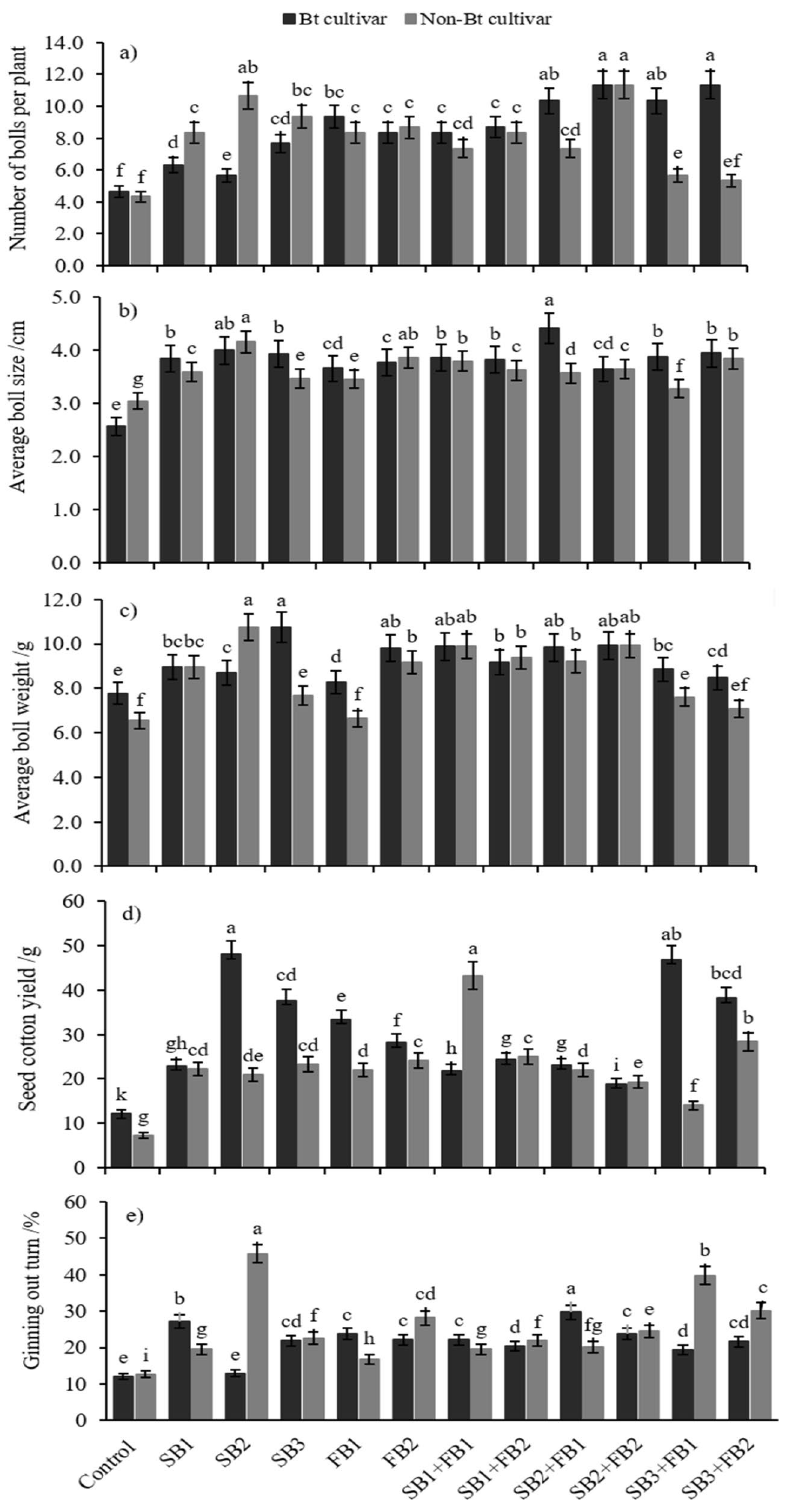
Fig. 2 Seed cotton yield and yield characteristics of Bt and non-Bt cotton cultivars grown with different levels and methods of B